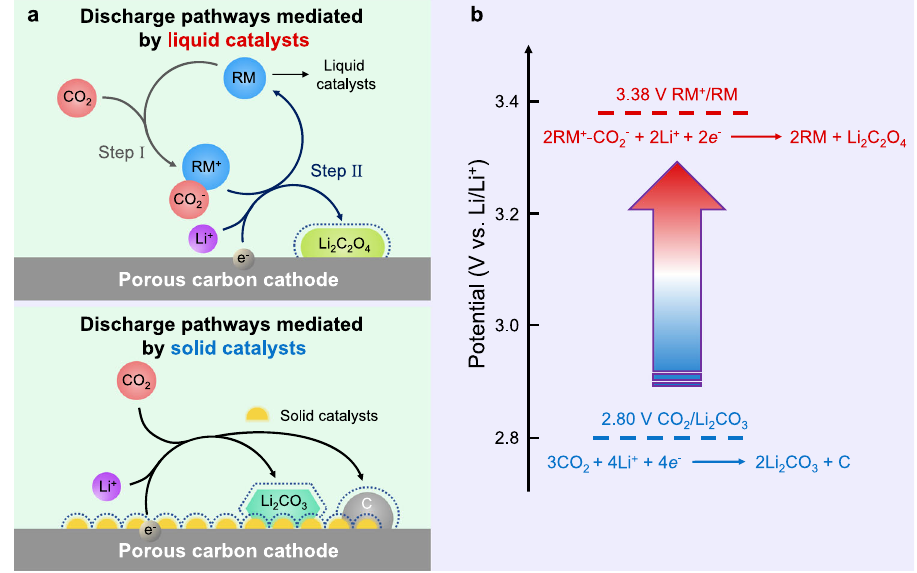
Fig. 1 | Schematiccomparisonofsolidcatalysts-mediatedand liquid catalysts- mediated discharge reactions in Li – CO 2 batteries. a In the presence of solid catalysts,CO 2 isreducedtocarbonandLi 2 CO 3 .Fourphasesareinvolved,including threesolidphasesonthecathodesurface(solid catalysts,Li 2 CO 3 ,and carbon)and liquidelectrolyte.Withtheuseofliquid catalysts,RMmoleculescapturedissolved CO 2 in electrolyte, and then the formed RM – CO 2 species are reduced to